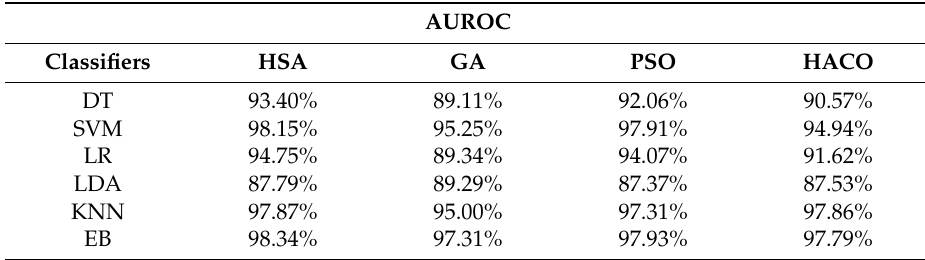
Table 7. Area under receiver operating characteristic curve of different pairs of feature selection and classifiers.